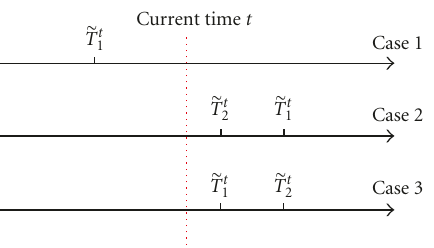
Figure 4: Illustration of three cases in the heuristic strategy.